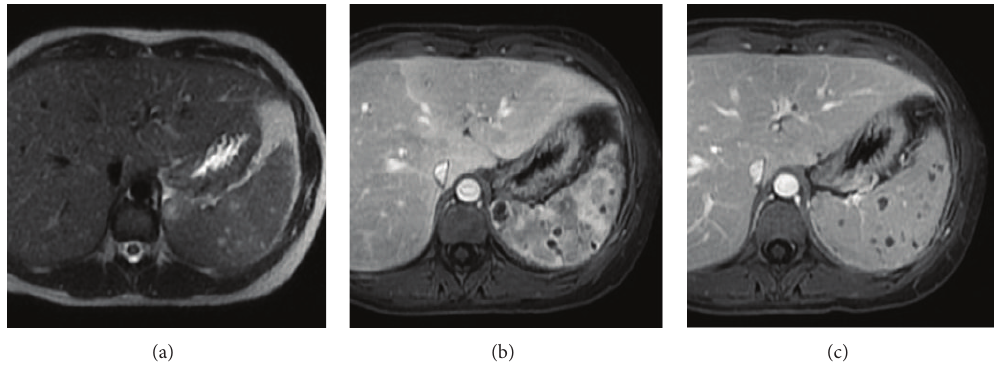
Figure 7: Microabscesses in an HIV patient with candidiasis. Axial T2wi SSFSE (a) and postcontrast axial 3D-GRE T1wi with fat suppression at the arterial (b) and venous (c) phases images. Multiple ill-defined T2w hyperintense lesions (a) with peripheral ring enhancement on gadolinium-enhanced images ((b) and (c)) are depicted, consistent with